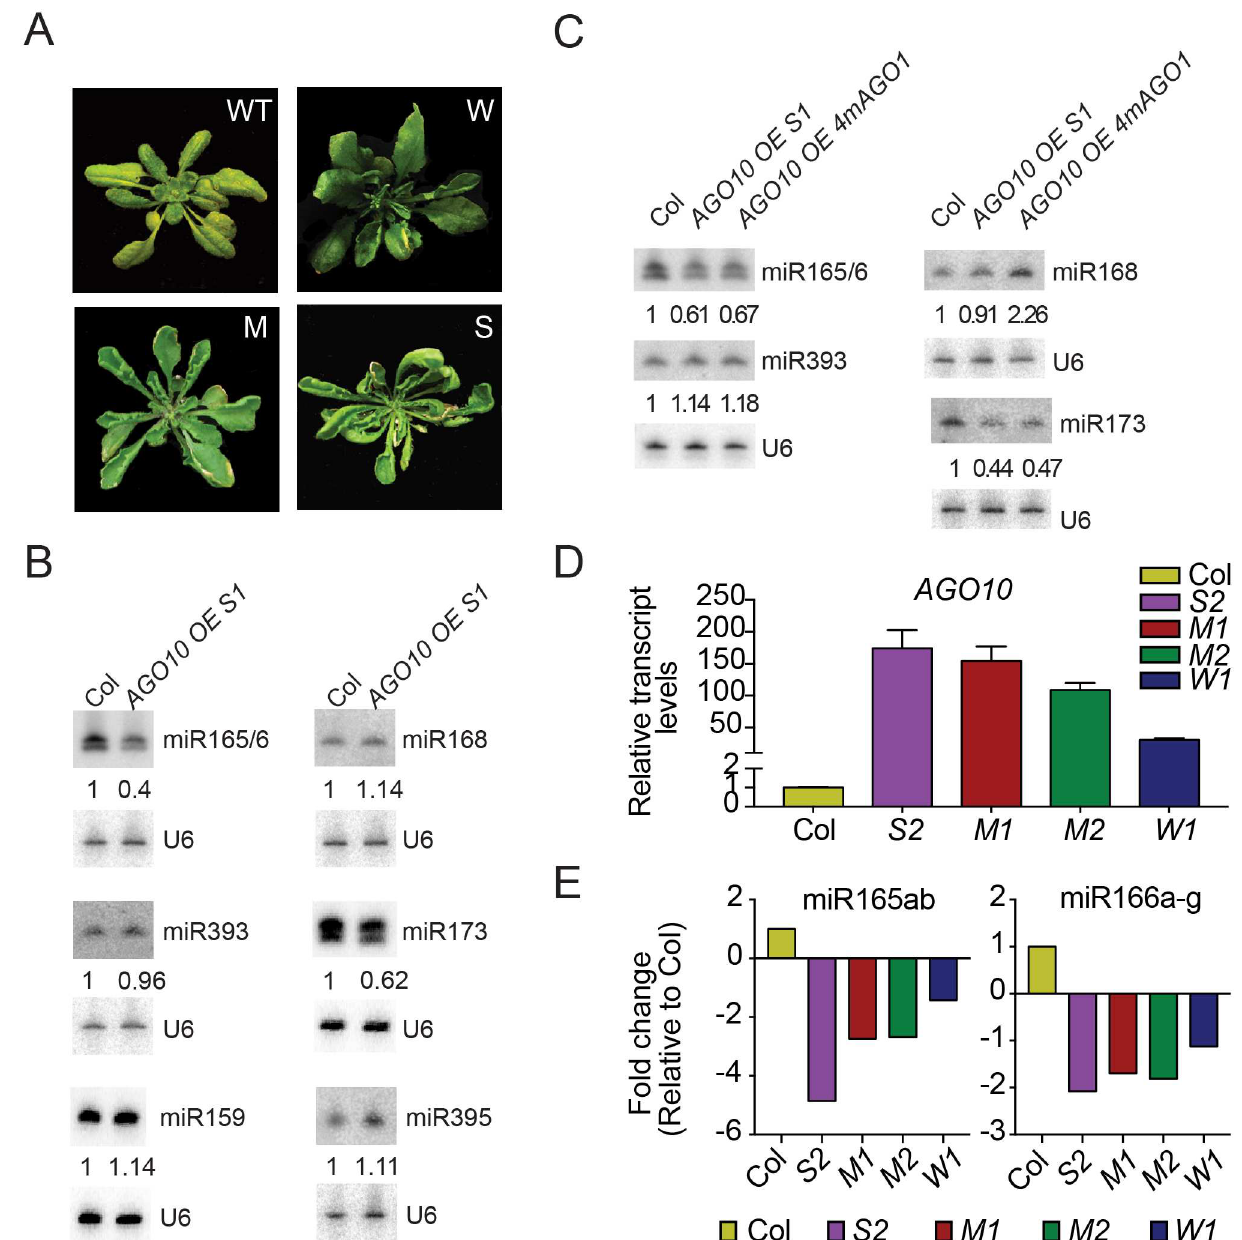
Fig 4. AGO10 overexpression causes reduced miR165/6 accumulation. (A) Phenotypesof wild type (WT) and AGO10 overexpression ( AGO10 OE ) lines in Weak (W), Moderate (M), and Strong (S) categories. The classificationof AGO10 OE lines was basedon the degreeof deviationfrom the wild-typeleaf phenotype. (B) The levels of six miRNAs in wild-typeand AGO10 OE S1 seedlings,as determinedby northernblotting. U6 served as the internalcontrol, and the numbers indicate the abundanceof the miRNAs in AGO10 OE S1 relative to wild type (Col). (C) The levels of four miRNAs in wild-type, AGO10 OE S1 , and AGO10 OE 4mAGO1 seedlings, as determined by northern blotting. U6 served as the internalcontrol, and the numbers indicate the abundanceof the miRNAs relative to wild type (Col). (D) Real-time RT-PCR to determine AGO10 transcript levels in wild type (Col) and four AGO10 OE lines. (E) Levels of miR165/6in various AGO10 OE lines as comparedto wild type (Col). The abundance of the miRNAs was determined by sRNA-seq. Underlying data can be found in the GEO databaseas series GSE87355. The raw data for panels (D-E) can be found in S1 Data.